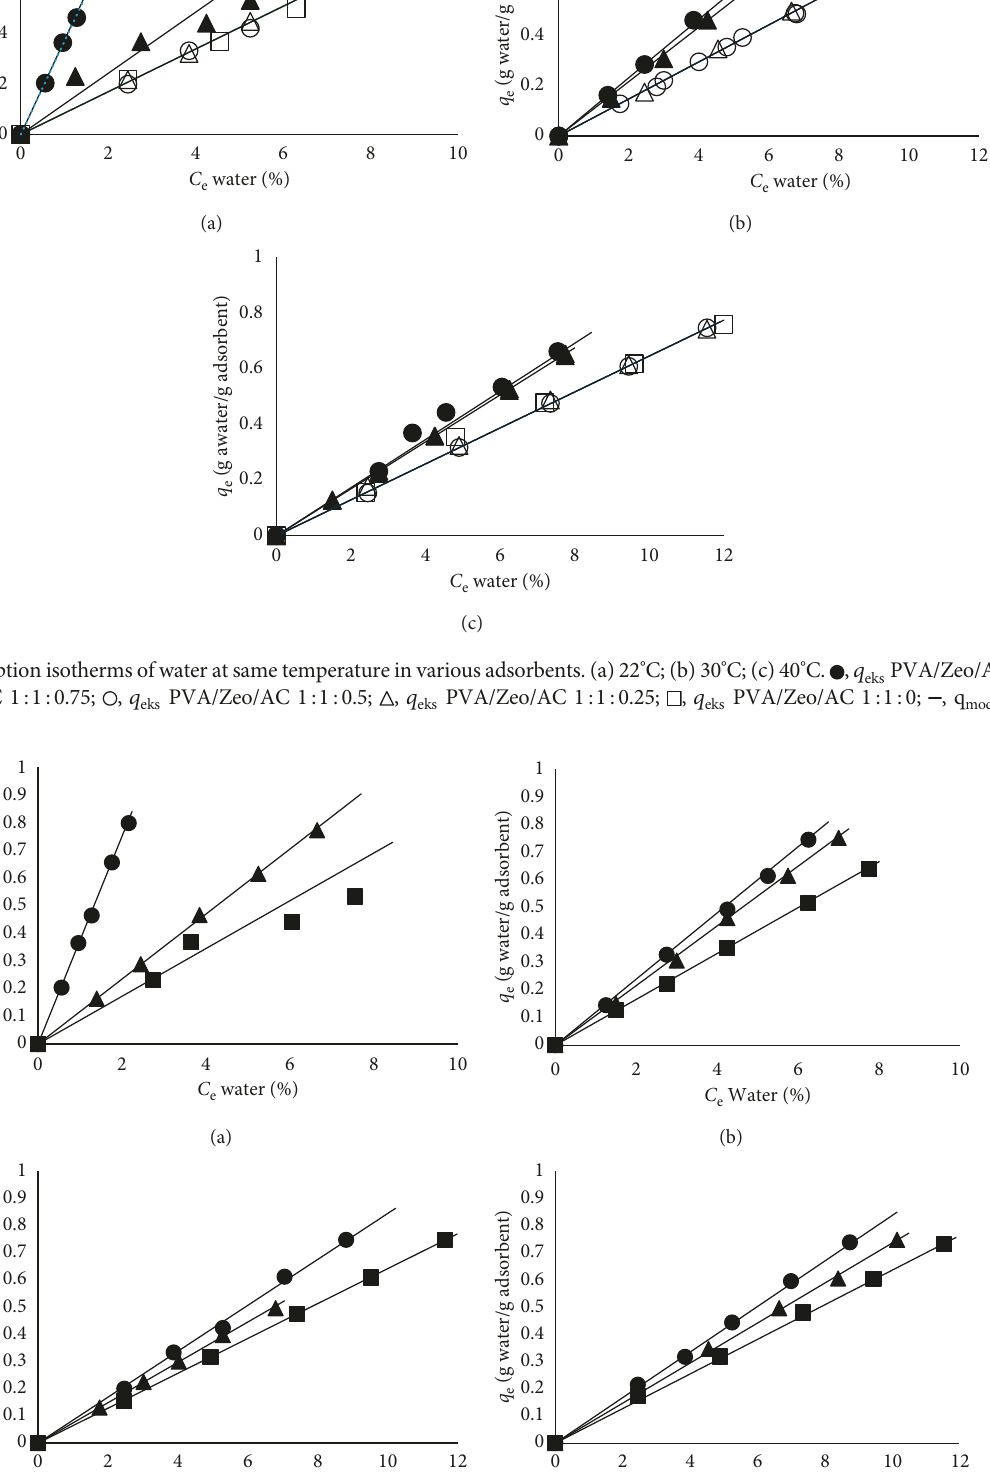
PVA/Zeo/AC 1:1:0.5; , q eks